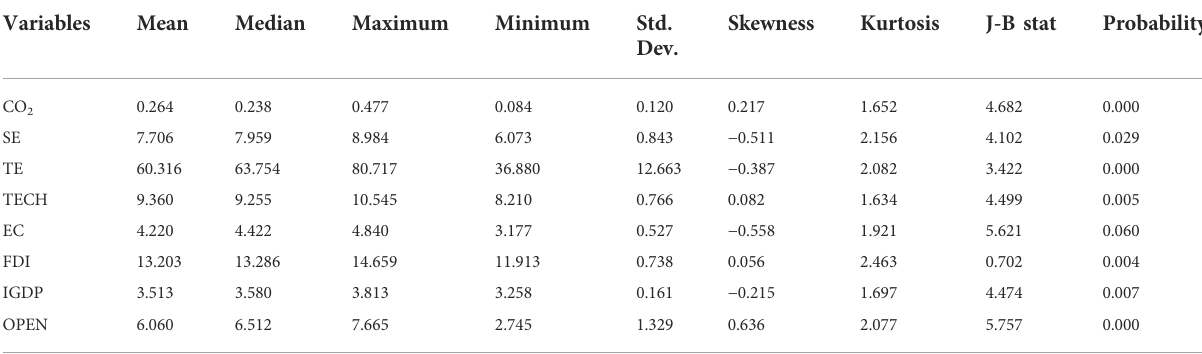
TABLE 3 Descriptive